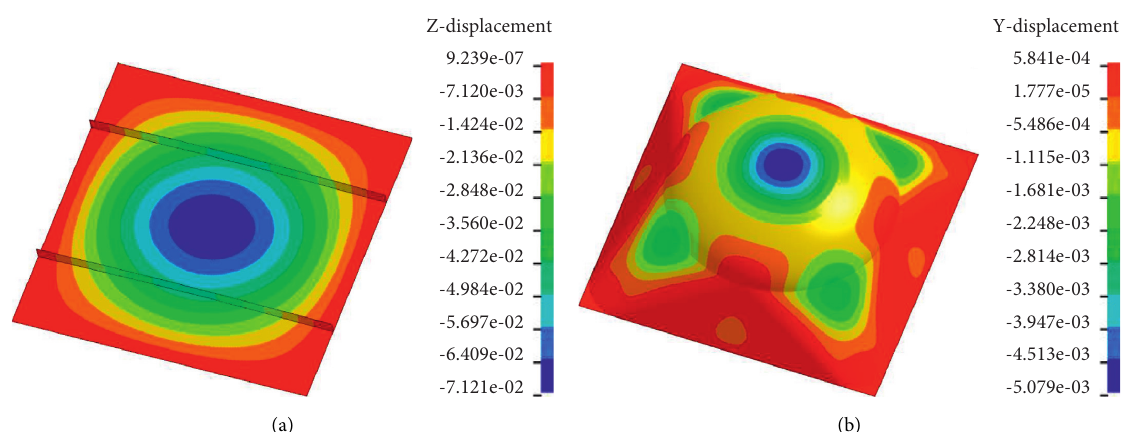
Figure 8: Displacement contour of the blast-resistant door: (a) RFBD2 and (b) EBD.